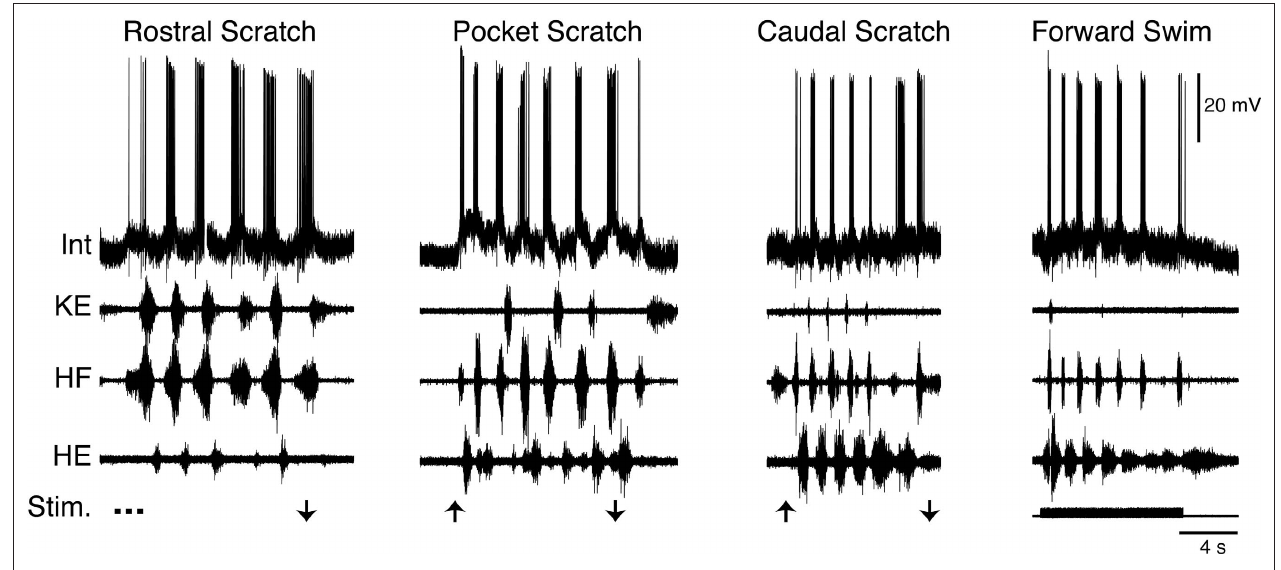
knee extensor; HF, hip flexor; HE, hip extensor; Stim., stimulus; arrows indicate scratch stimulus onset/offset. Modified from Berkowitz (2008), with permission of the American Physiological